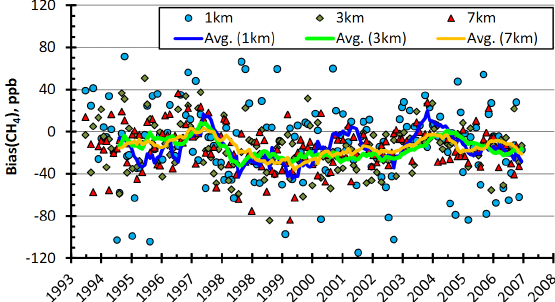
Fig. 9. Time series of model bias (modelled CH 4 concentration minus observed) and the averaged (moving average with period 12) value of the bias for the 1, 3, and 7 km levels over Surgut (61.25°N, 73.43°E) for the period 1993–2007.